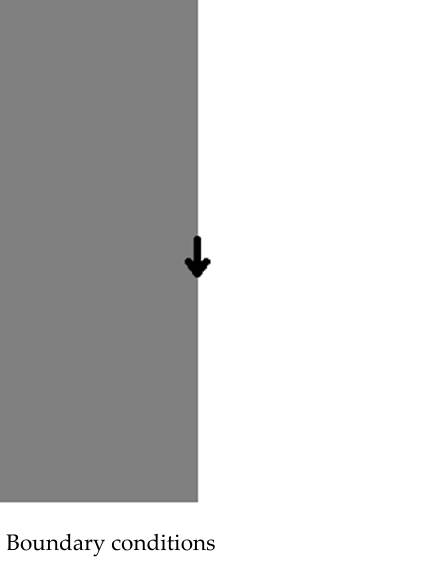
Figure 7. Schematic of the short cantilever problem definition.